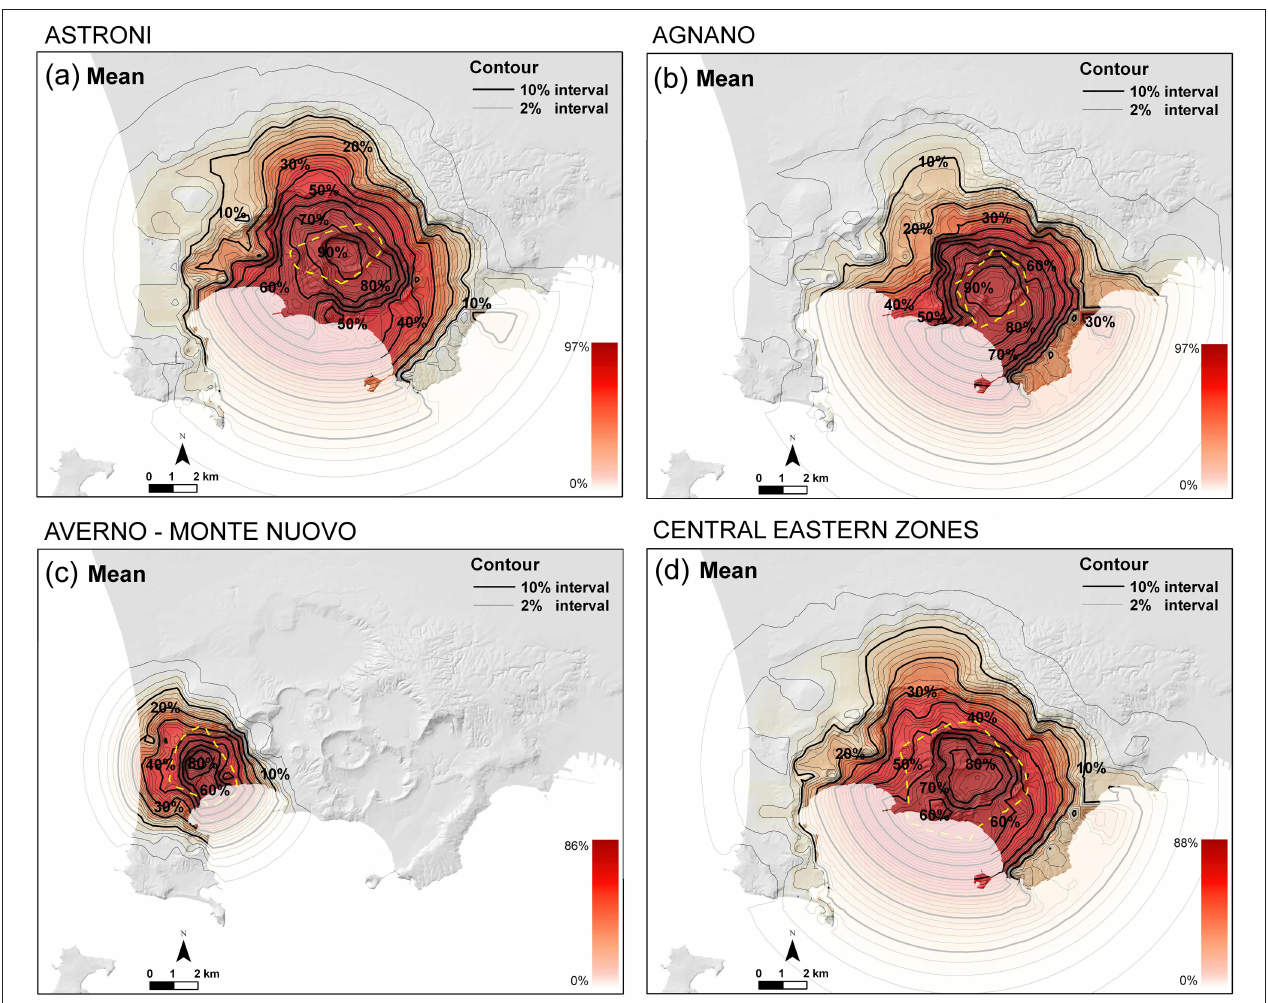
FIGURE 6 | PDC invasion hazard map based on the vent opening map displayed in Figure 2a and the areal size distributions in Figure 3b , with the additional condition of the vent to be inside specific areas of the caldera. (a) Astroni, (b) Agnano, (c) Averno—Monte Nuovo, (d) central-eastern zones. Contours and colors indicate the mean percentage probability of PDC invasion conditional on the occurrence of an explosive event